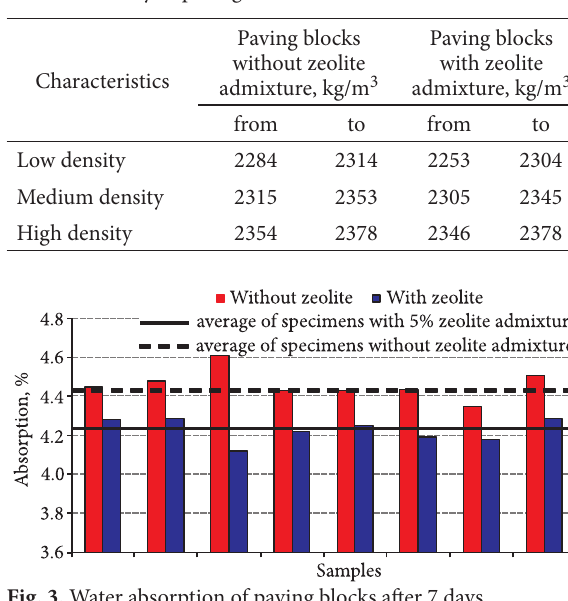
Fig. 3. Water absorption of paving blocks after 7 days